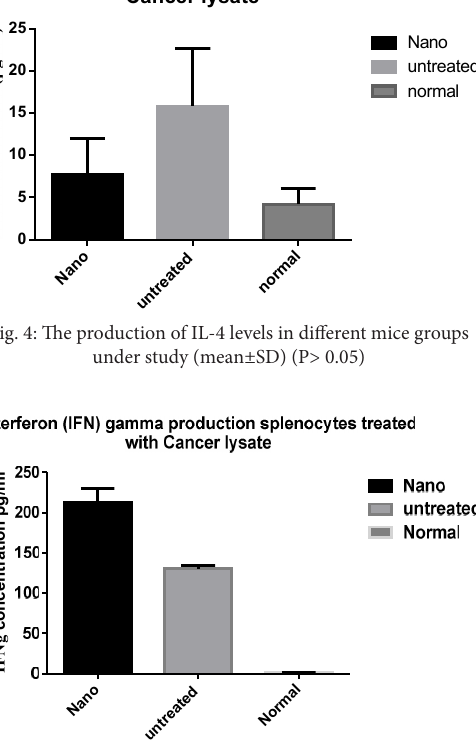
Fig. 5: The production of IFN- γ levels in different mice groups under study (mean±SD) (P> 0.05).